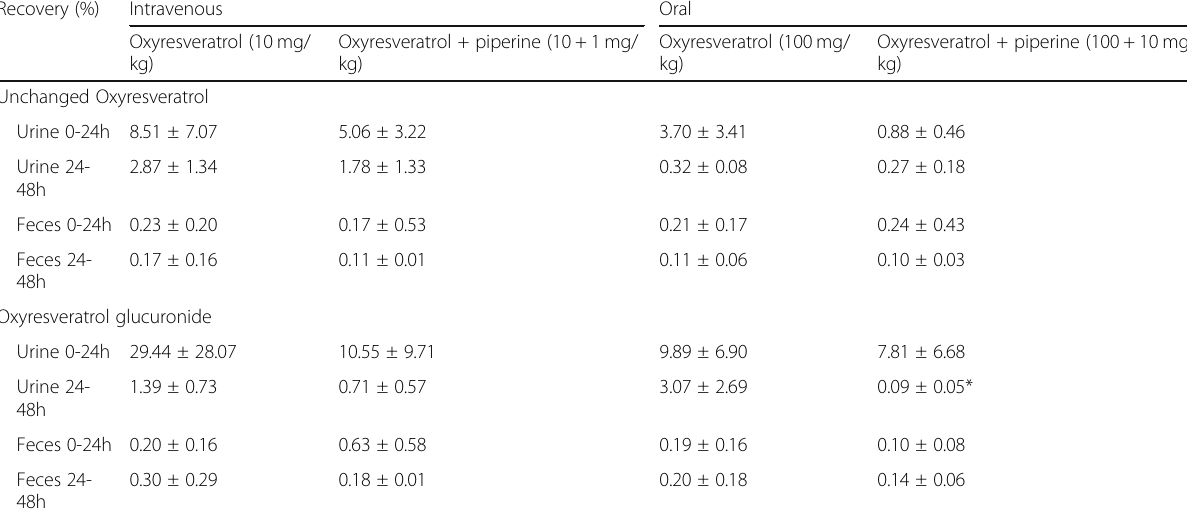
Table 3 Percent recovery of oxyresveratrol alone and in combination with piperine Recovery